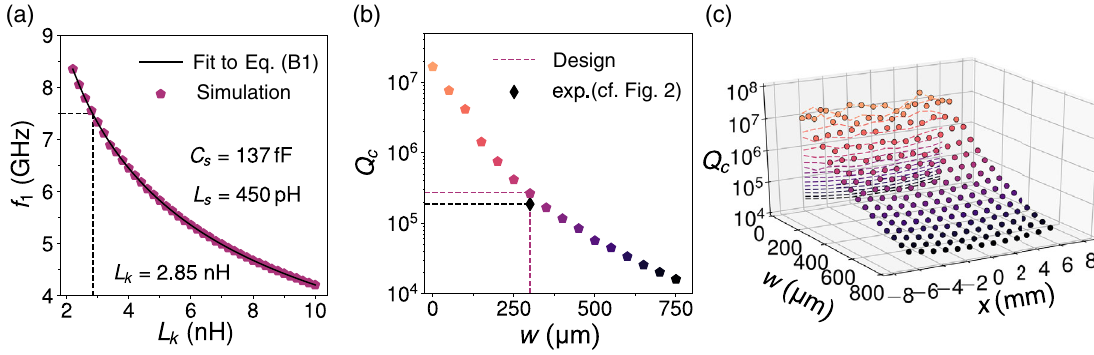
FIG. 7. Finite-element method simulations of the linearized circuit. (a) Simulated transition frequency f 1 of the linearized circuit obtained using the eigenmode solver of a commercial finite-element method simulator (high-frequency structure simulator). For the simulation, the grAl volume is substituted with a lumped-element inductance L which we sweep from 2 to 10 nH in order to fit the shunt capacitance C k s 137 fF and L 450 pH. As indicated by the and additional geometric inductance L of our design using Eq. (B1). We extract C s s ¼ s ¼ 2 . 85 nH. (b) Simulated external quality factor Q dotted cursors, the measured frequency f 1 ¼ 7 . 4887 GHz corresponds to a value L k ¼ c 2 . 85 nH. Similarly to the design of Ref. [60], by closing the gap we can vary the as a function of the gap w in the outer electrode for L k ¼ external quality factor by 3 orders of magnitude. For clarity [cf. panel (c)], the color of the markers is related to the value of w . The colored dashed lines indicate the design value for the experiment and the black marker indicates the measured external quality factor Q c ¼ 1 . 9 × 10 5 (see Fig. 2). (c) Simulated external quality factor as a function of the lateral chip position x and gap width w . The value of x is measured from the center of the waveguide to the symmetry axis of the circuit. Because of the large aspect ratio of the waveguide ’ s cross section ( 30 mm × 6 mm), the external quality factor varies by less than a factor of 2 along